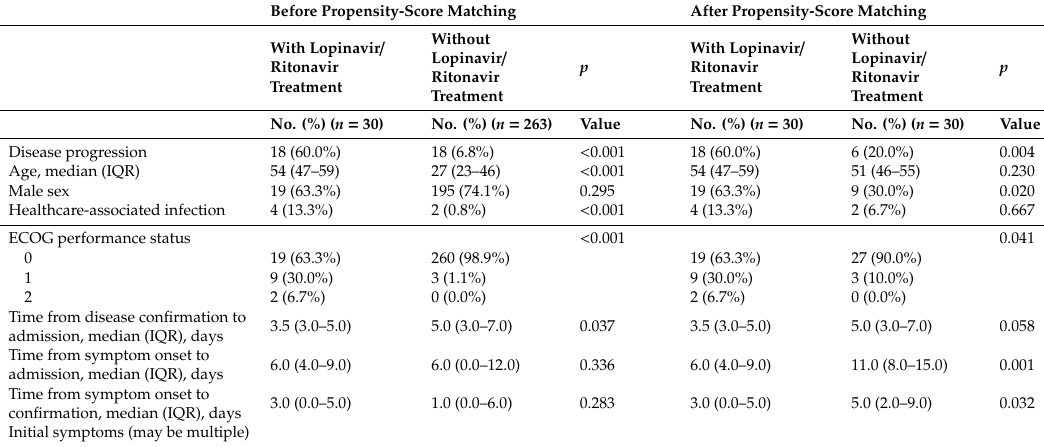
Table A4. Lopinavir / ritonavir treatment outcomes in COVID-19 patients before and after propensity-score matching *. Before Propensity-Score